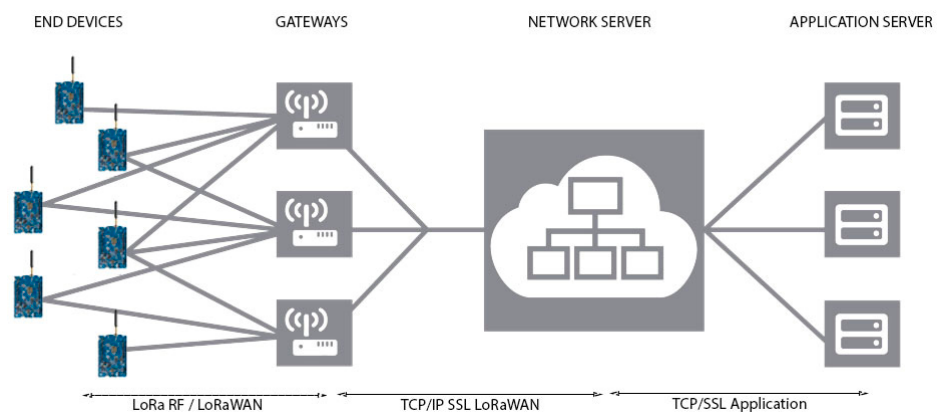
Figure 2. LoRaWAN